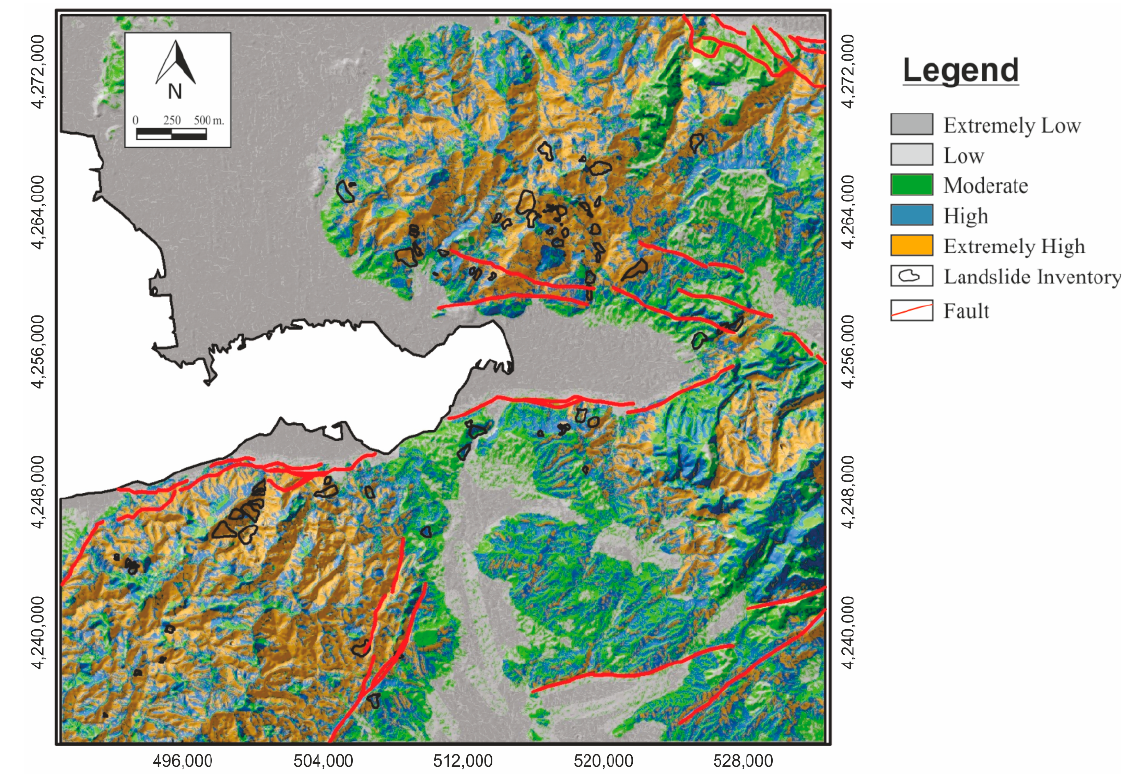
Figure 10. Landslide susceptibility map prepared with IOE method.